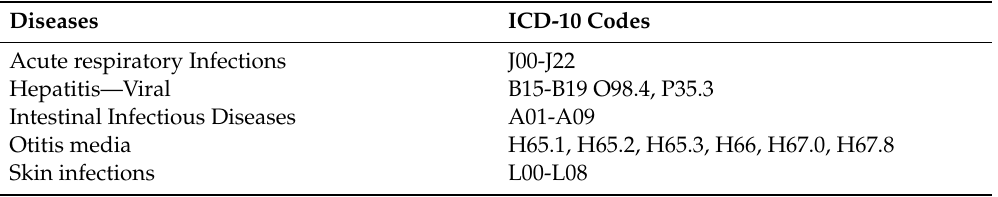
Table A1. List of International Statistical Classification of Diseases and Related Health Problems Revision 10 (ICD-10) codes for diseases related to the home environment (used for evaluation of health outcomes from Housing for Health).